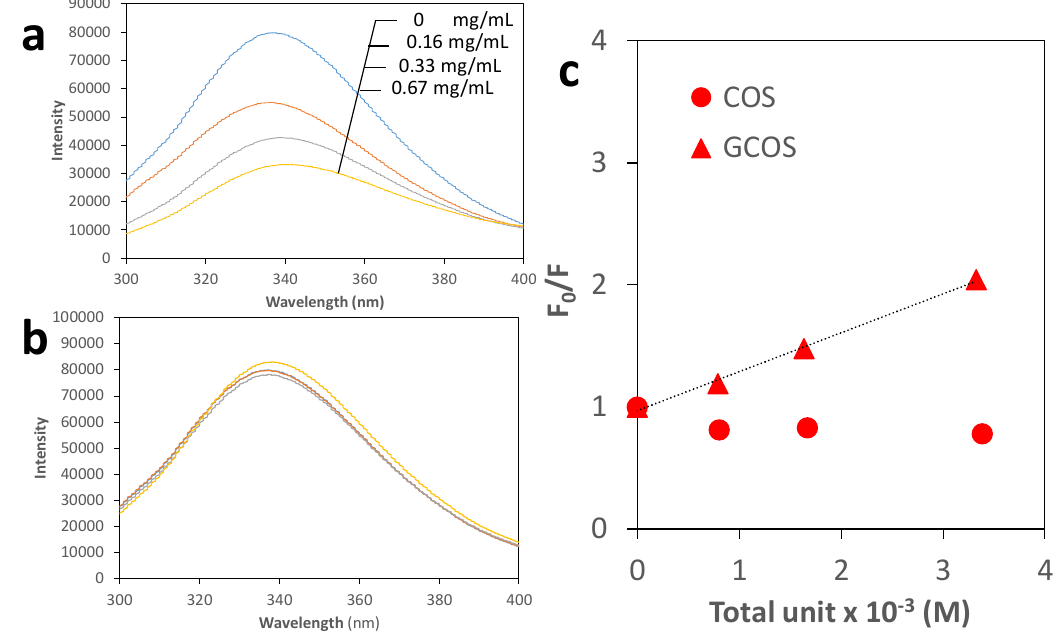
Figure 4. Fluorescence spectra (excitation wavelength: 275 nm) of 0.42 mg/mL BSA in the presence of 0, 0.16, 0.33, 0.67 mg/mL GCOS (0, 0.79, 1.64, 3.32 × 10 −3 M, respectively) or COS (0, 0.81, 1.67, 3.39 × 10 −3 M, respectively) in a 0.1 M Tris–HCl buffer (pH 7.4) ( a or b , respectively) and their Stern–Volmer